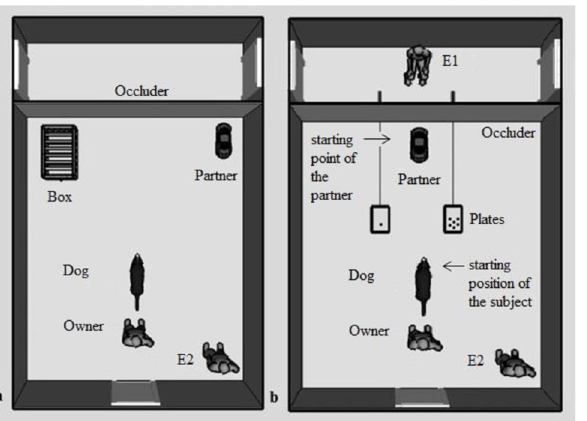
Fig 1. The experimental set up. (a) Phase 2 in the Helper UMO and Helper UMO Control groups, (b) Phase 3: the partner was either a human (E2) or the UMO. The experimental set up in Phase 1 was the same as in Phase 3, but without the presence of the partner. The drawing is not to